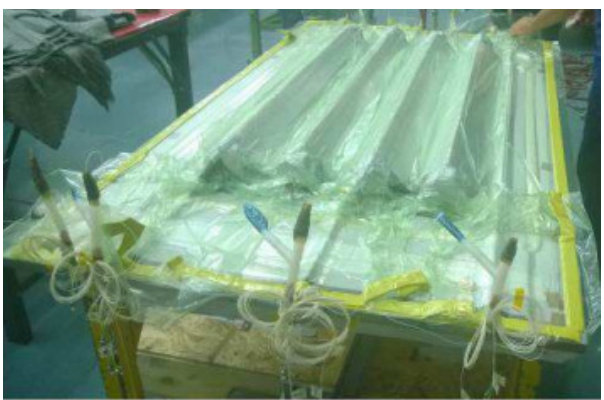
Figure 11. Final panel with sealed vacuum bag, ready for the infusion.